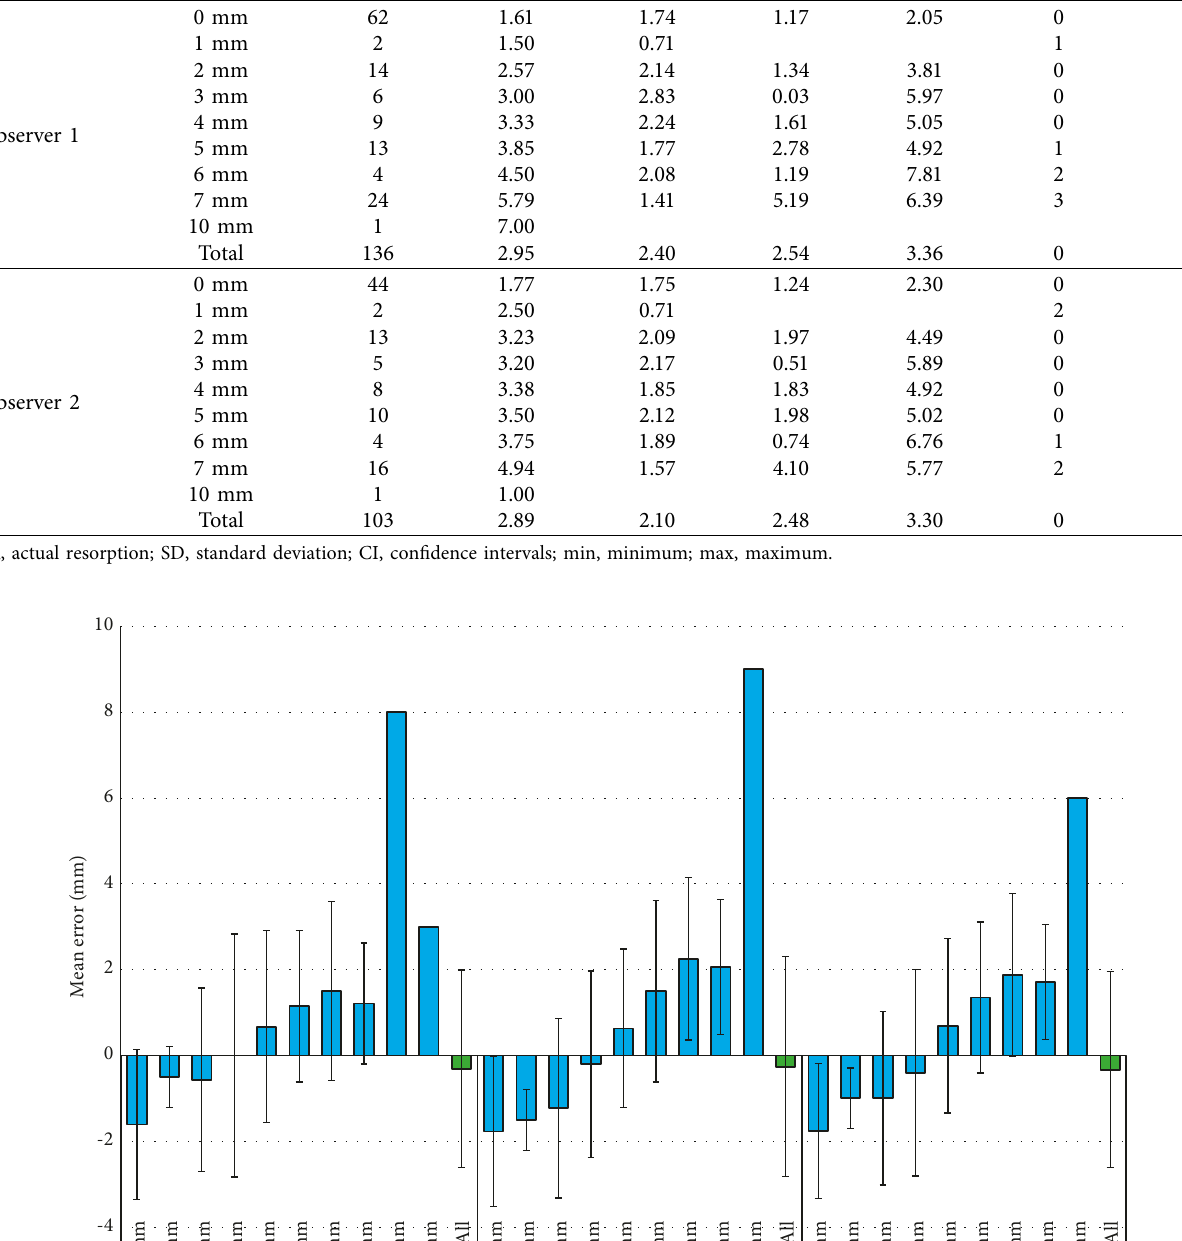
Table 1: Descriptive statistics and 95% CIs for the extents of radiographic resorption estimates (mm) observed by each of the radiograph examiners in the case of each of the extents of actual resorption (mm).